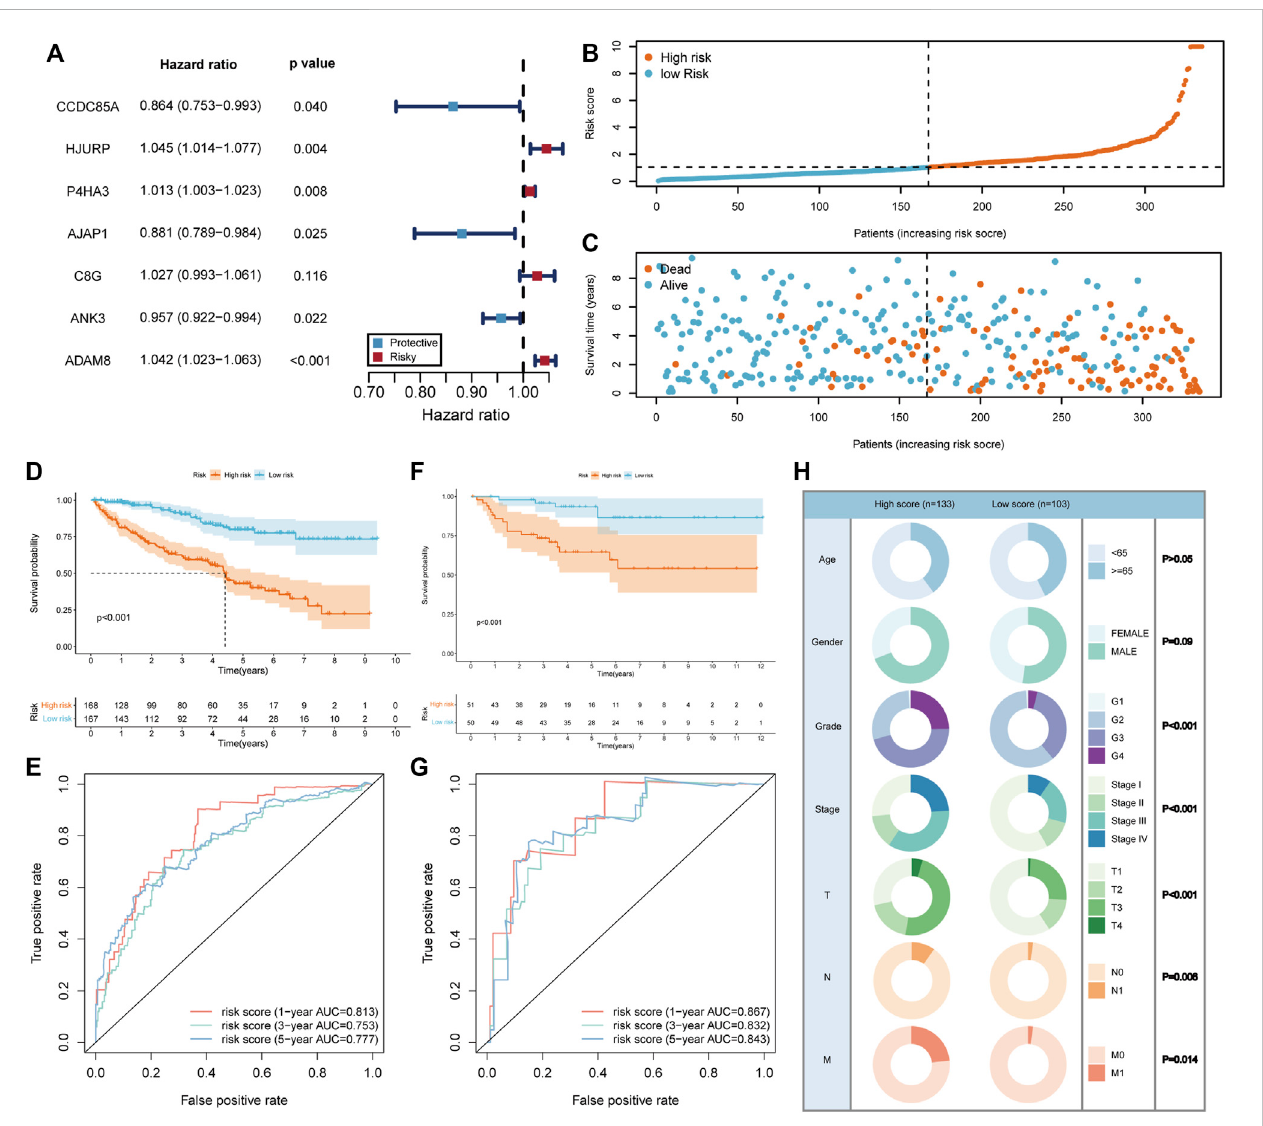
(B, C) Distribution of the risk scores and survival status of ccRCC patients in the TCGA training cohort. (D, F) The Kaplan Meier survival curve comparing the overall survival between high and low risk groups in the TCGA training cohort and E-MTAB-1980 cohort respectively. (E, G) The tROC curve of the risk score for 1-, 3-, and 5-year survival in the TCGA training cohort and E-MTAB-1980 cohort. (H) Comparison of the clinical features in high and low risk